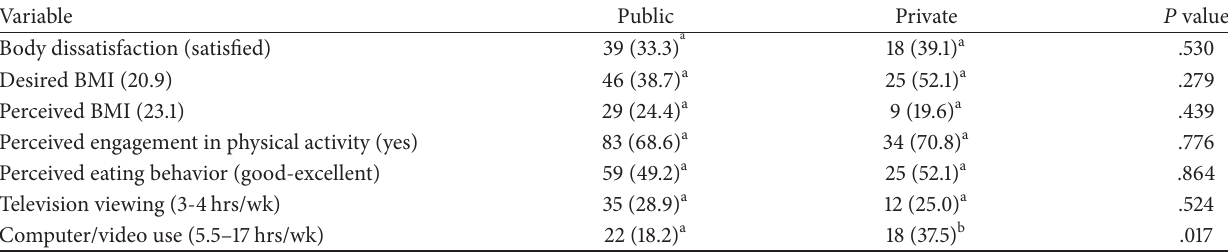
Table 2: General characteristics by type of school (public versus private).